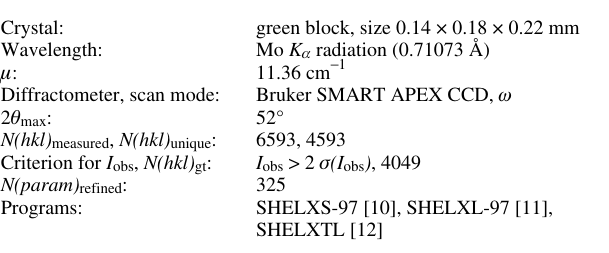
Table 1. Data collection and